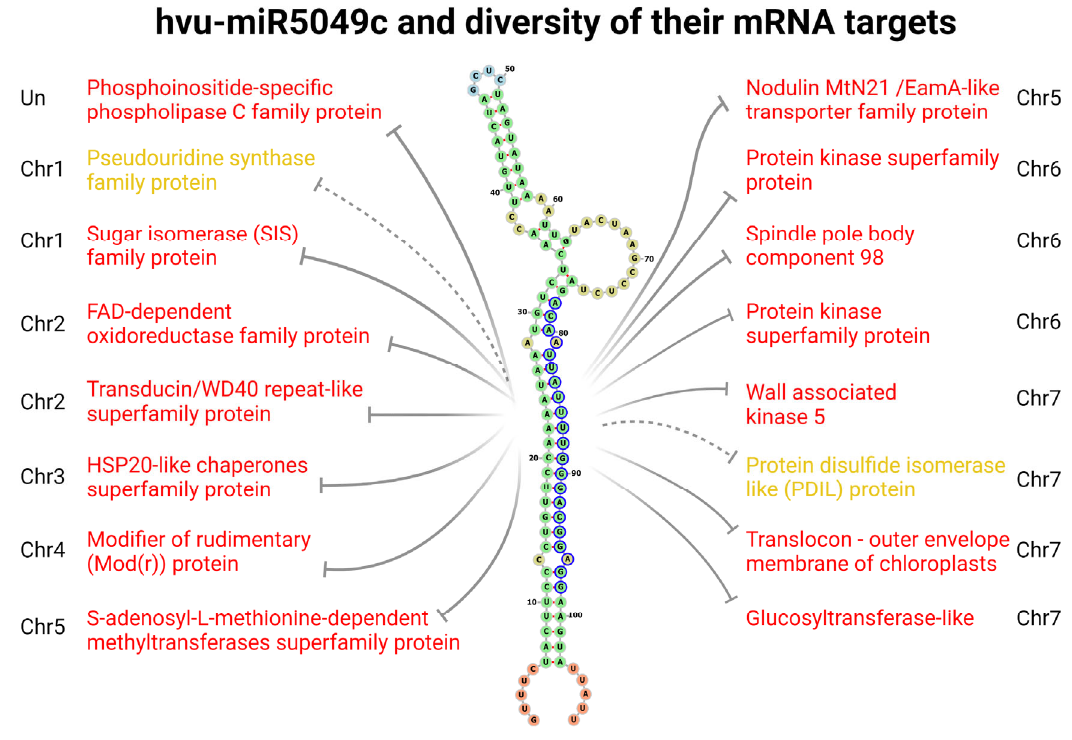
Figure 5. Barley pri ‐ miR5049c structure together with miR5049 putative mRNA targets. pri ‐ miRNA structure was computed via RNAfold web server [149] and visualized in the form of a Forna diagram [150]. Nucleotides in blue circles correspond to the mature 21nt ‐ long miRNA region. Grey lines depict inhibition of specific mRNA targets (if the line is full and the description is in red, mRNA cleavage was predicted, according to TarDB: “Cleavage is predicted if miRNA 5 ′ positions 9–11 have the perfect match”). Chromosome numbers correspond to the location of genes encoding particular mRNAs, Un stands for Unplaced locus .